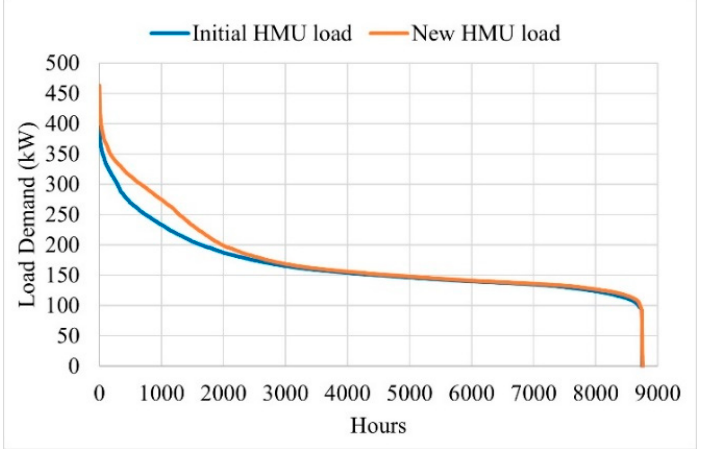
Figure 8. Comparison of load duration curves in the HMU campus considering the addition of EV chargers.